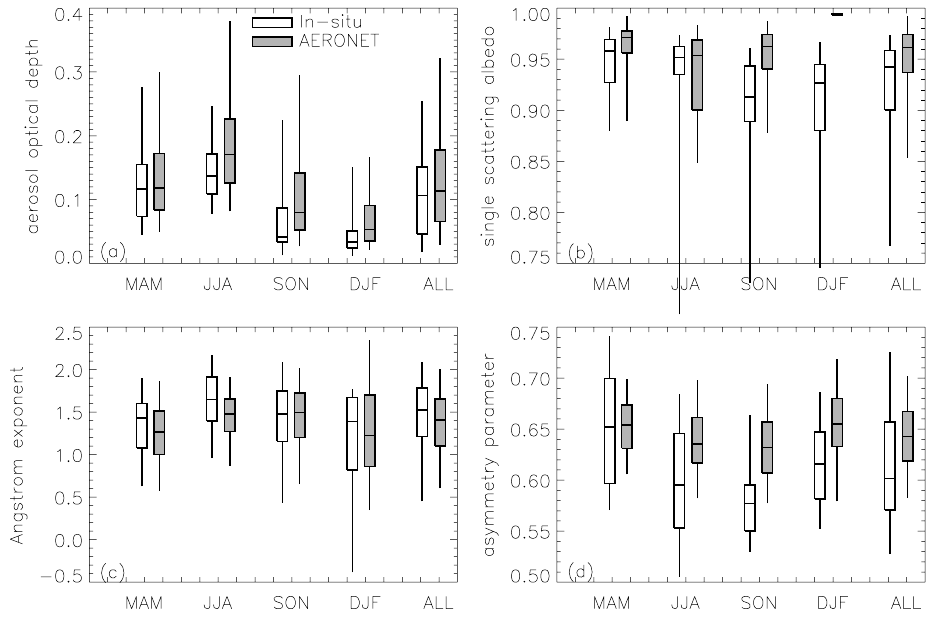
Fig. 3. Comparison of in situ aerosol optical properties adjusted to ambient T , P , RH AERONET values (a) aerosol optical depth (at 500nm), (b) single scattering albedo (at 673nm), (c) ˚Angstr¨om exponent (441/673nm pair) (d) asymmetry parameter (at 673nm). The line in the middle of the box is the median, while the boxes represent the upper and lower quartile and the “whiskers” represent the 5th and 95th